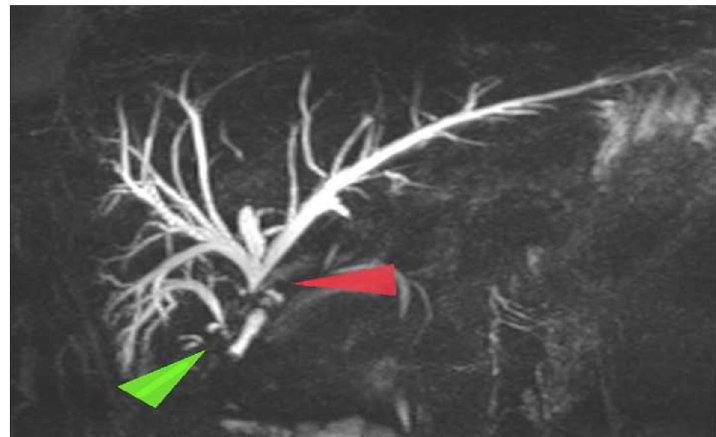
Fig. 8 3D-MRCP. Post-cholecystectomy ligation of aberrant right posterior hepatic duct to the CHD “green arrowhead”. This is associated with concomitant CHD injury “red arrowhead”. Strasberg Type E5; Bismuth-Corlette Type 5 bile duct injury. Consequent moderate intra-hepatic biliary backpressure changes seen